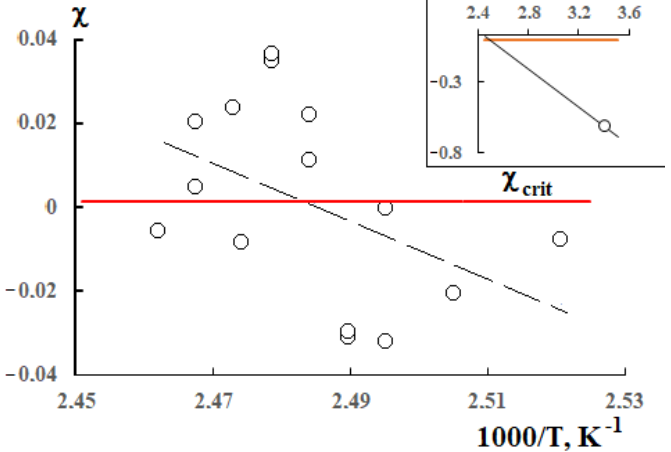
Figure 12. Dependence of the Flory–Huggins parameter on the inverse temperature. The red line is the critical value of the Flory–Huggins parameter. The inset shows the position of the figurative point at t = 20 °C.